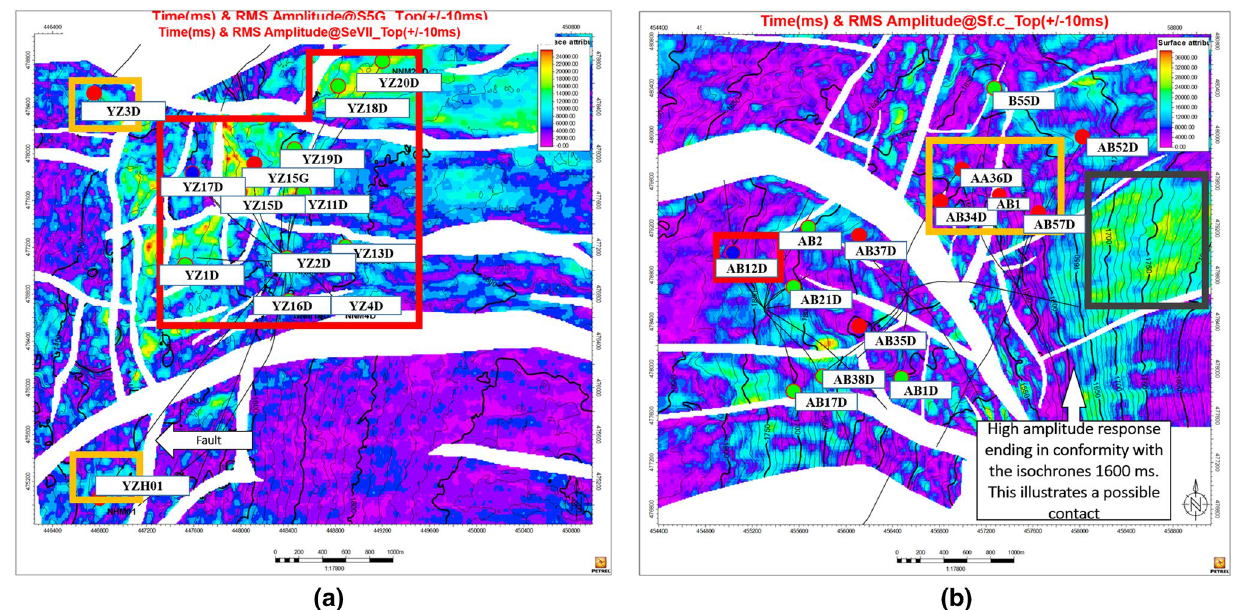
Fig. 8 Reservoir RMS amplitude map a SeVII; b AB